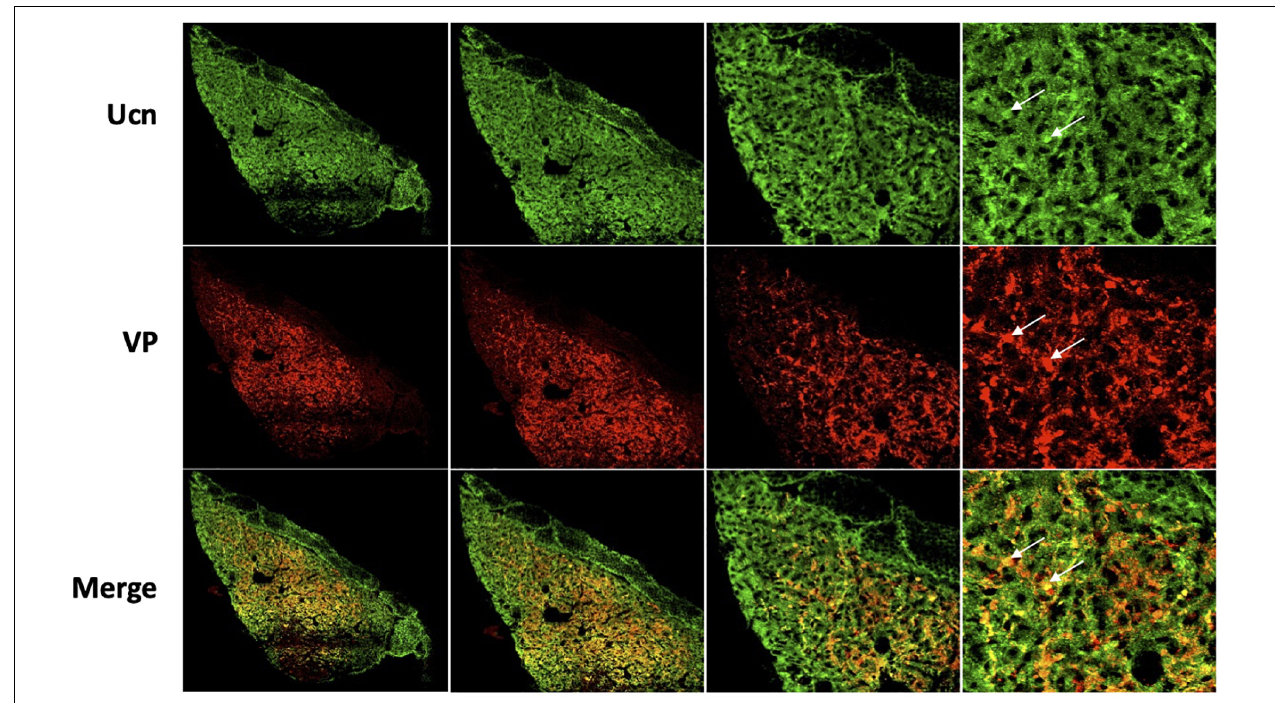
FIGURE 8 | Representative images of colocalisation of Ucn with VP in the posterior pituitary. Double-labelling with antibodies directed against Ucn and VP showed an apparent level of colocalisation within a proportion of vasopressin containing terminals within the posterior pituitary. Images show staining of Ucn throughout the posterior pituitary with expression located within small punctate vasopressinergic regions. Ucn, Urocortin; VP, arginine vasopressin. Scale Bar = 100 µ